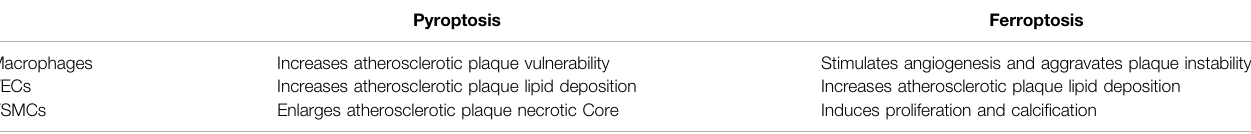
TABLE 1 | Comparison and summary of the effects of pyroptosis and ferroptosis on different